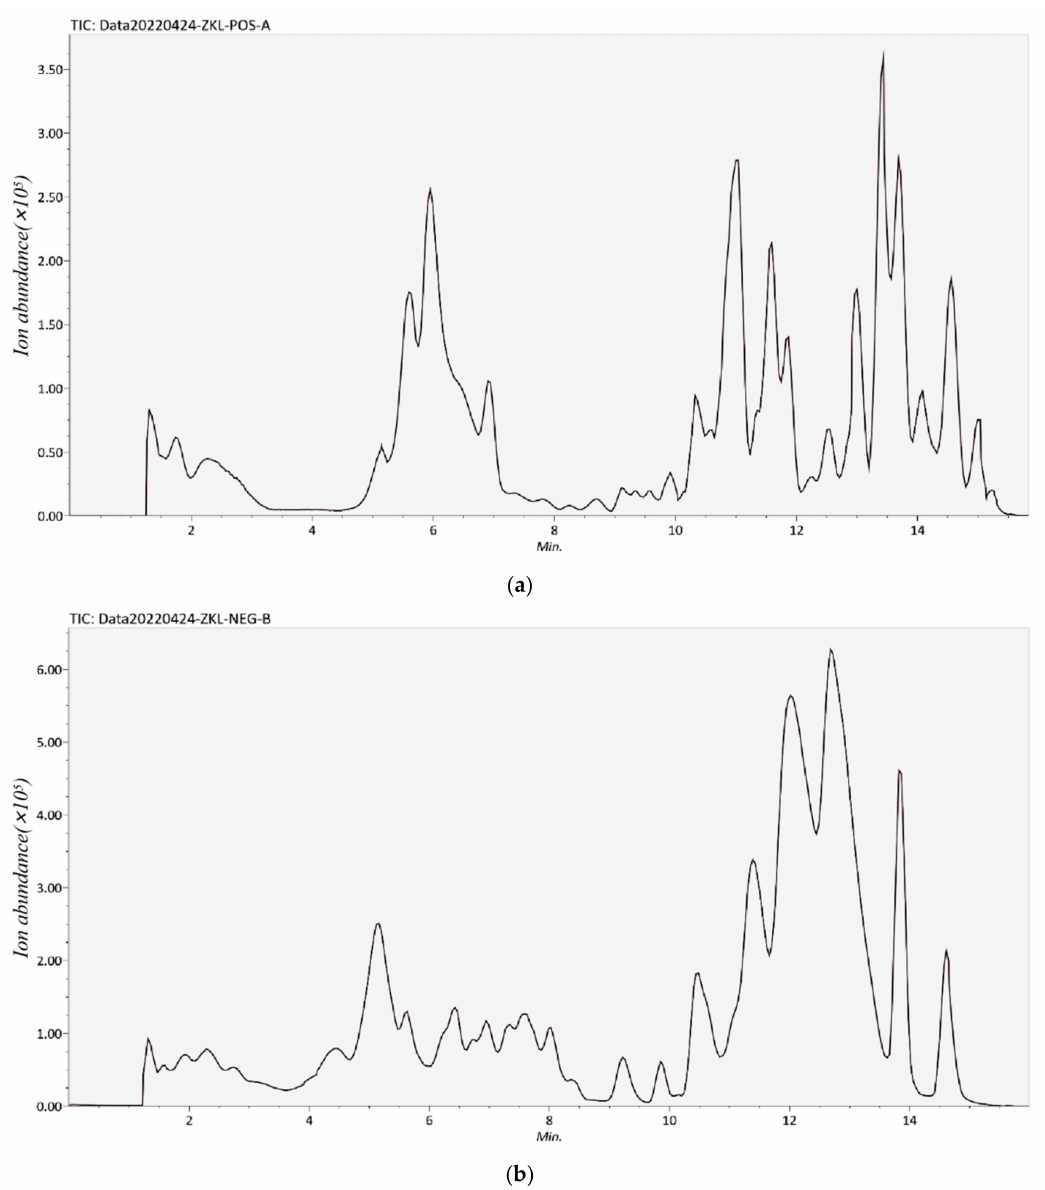
Figure 1. Base peak intestine chromatograms of RSE in positive ion mode ( a ) and negative ion mode ( b